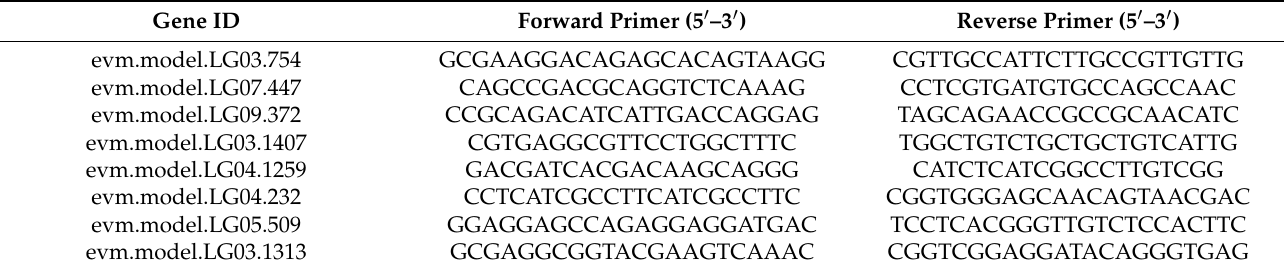
Table 1. Specific primer sequences used to verify transcriptomic sequencing